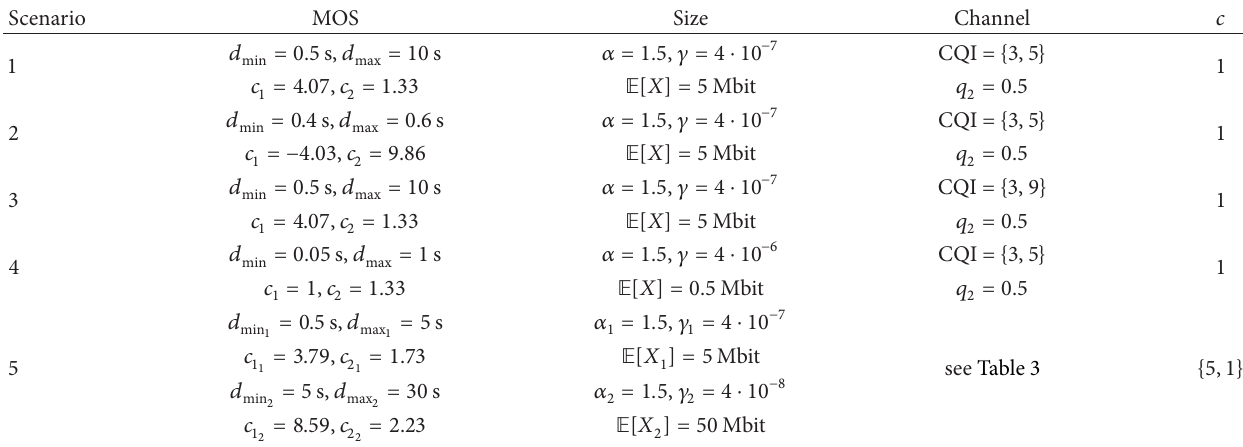
Table 2: Parameter set in the experimental scenarios.